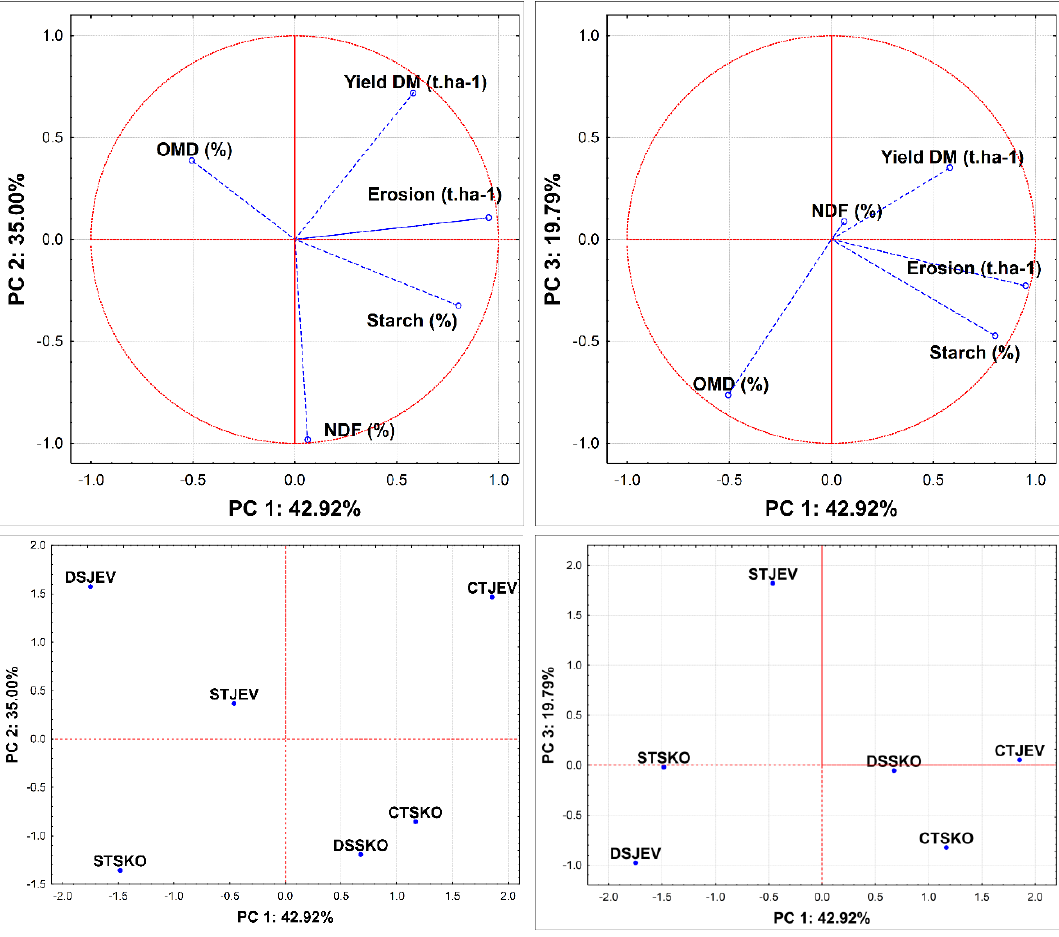
Figure 4. Soil loss erosion (t ha − 1 ) and surface runoff (mm) of analysed treatments in the period 2016– 2018.